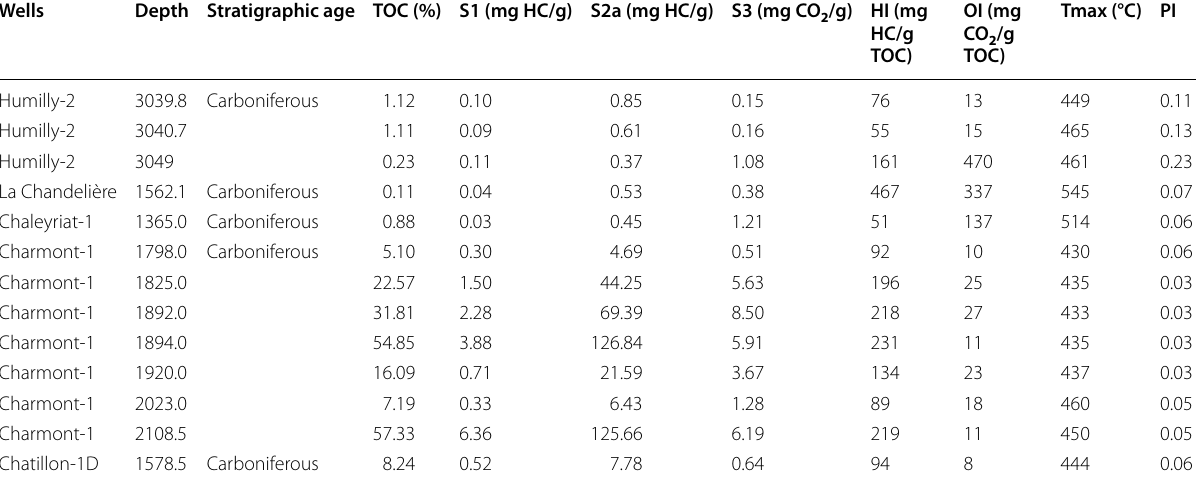
Table 2 Rock–Eval pyrolysis results of Carboniferous sections in the studied wells